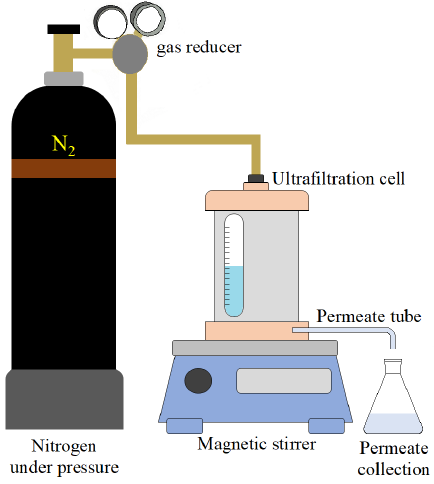
Figure 3. The scheme of ultrafiltration set-up.